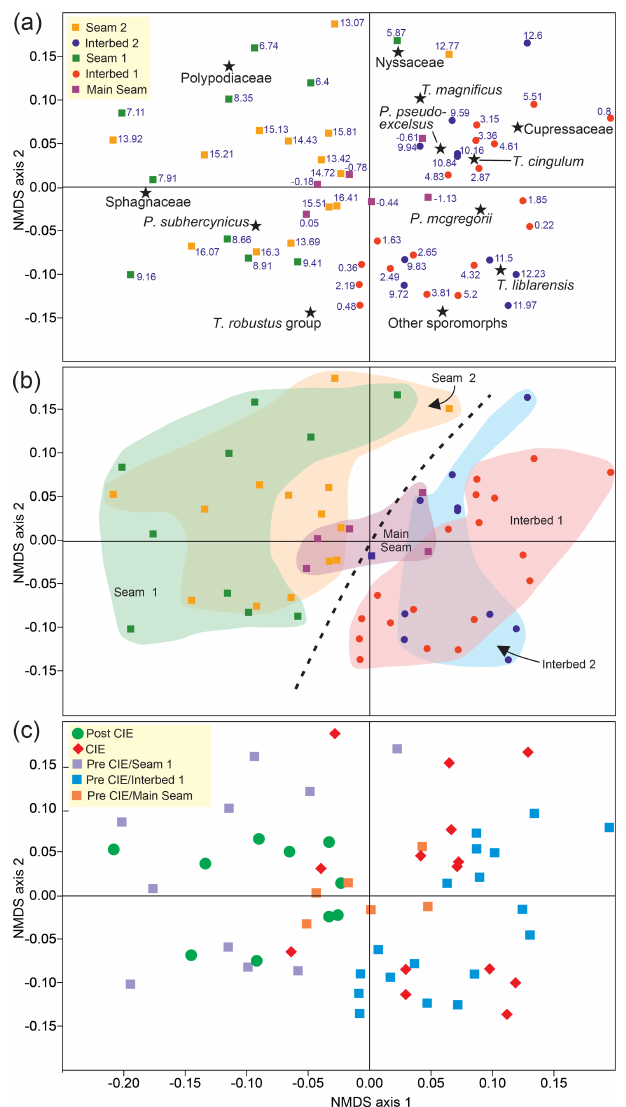
Figure 6. Nonmetric multidimensional scaling (NMDS) of palyno- logical data from the Schöningen Formation, comprising 59 sam- ples from the top of the Main Seam up to the top of Seam 2, using the Bray–Curtis dissimilarity and the Wisconsin double standard- ized raw data values. (a) Scatter plot of the first two axes showing the arrangement of samples and taxa. The different symbols repre- sent samples of the different lithological units. (b) Scatter plot of the first two axes showing the arrangement of samples with frames that indicate different lithological units in the succession. (c) Scatter plot of the first two axes showing the arrangement of samples separated by different symbols in pre-, peak-, and post-CIE